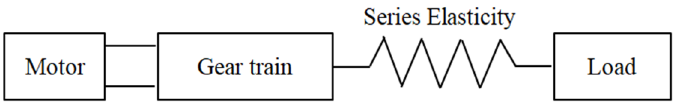
Figure 1. Concept of the series elastic actuator drive.